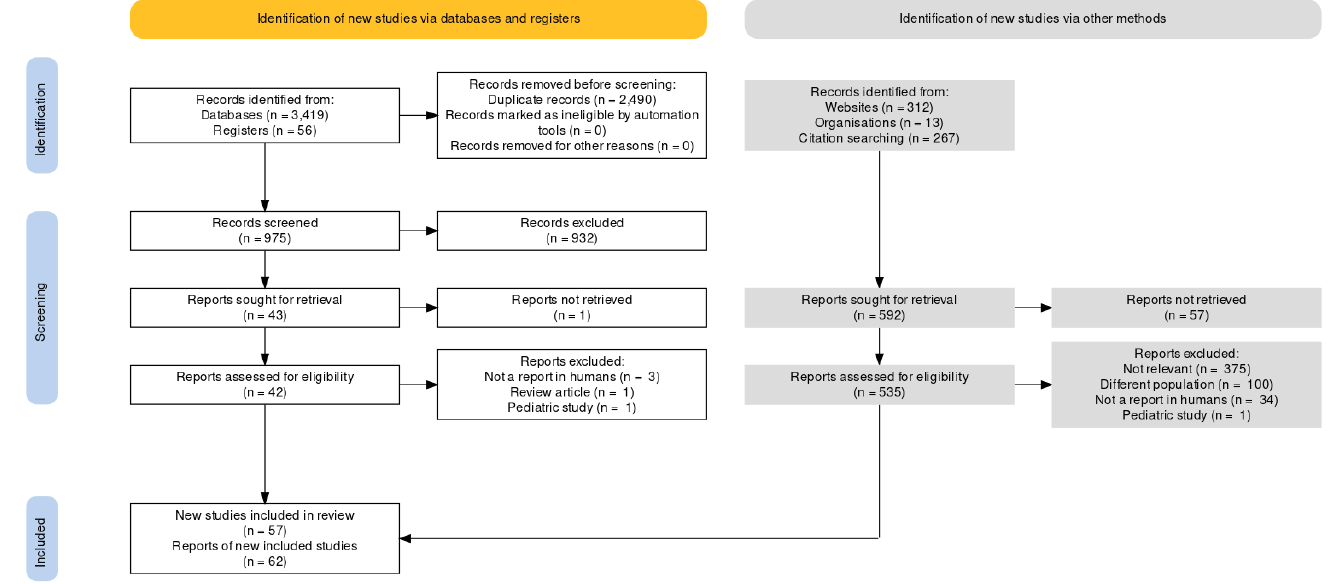
Figure 1 Example of a “PRISMA 2020 flow diagram for new systematic reviews which included searches of databases, registers and other sources” made using the R ShinyApp [1, 6,